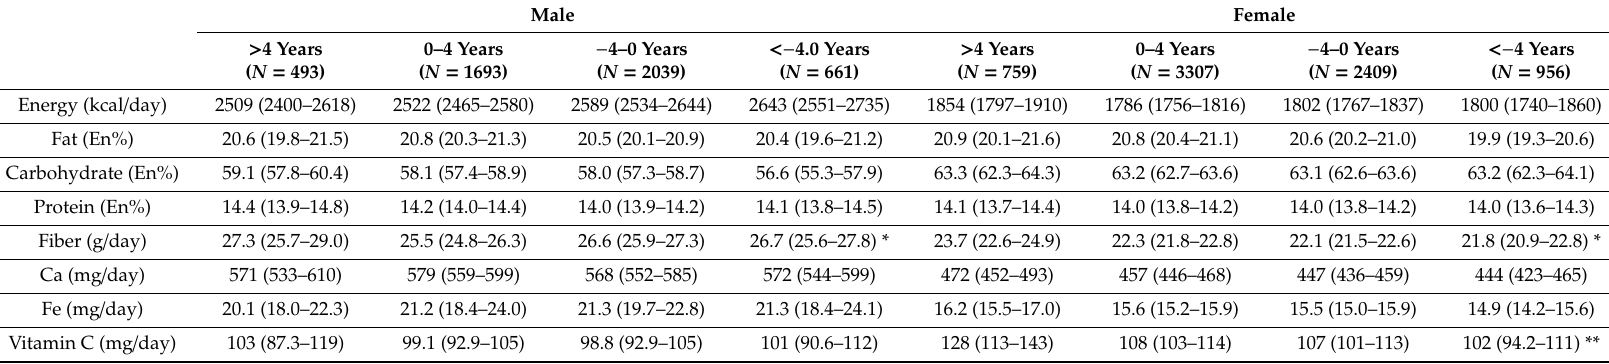
Table 3. Adjusted mean 1 and 95% confidence intervals of major nutrient intake calculated from 24-h recall method according to genders and the age-gap groups 2